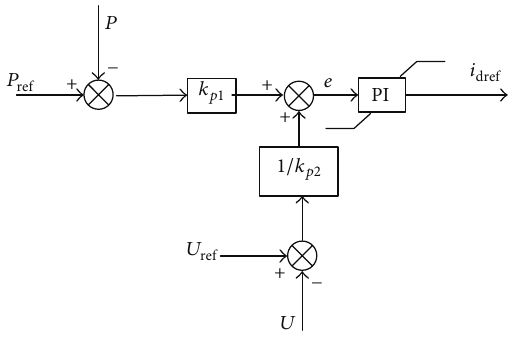
Figure 6: Block diagram of DC voltage droop control.